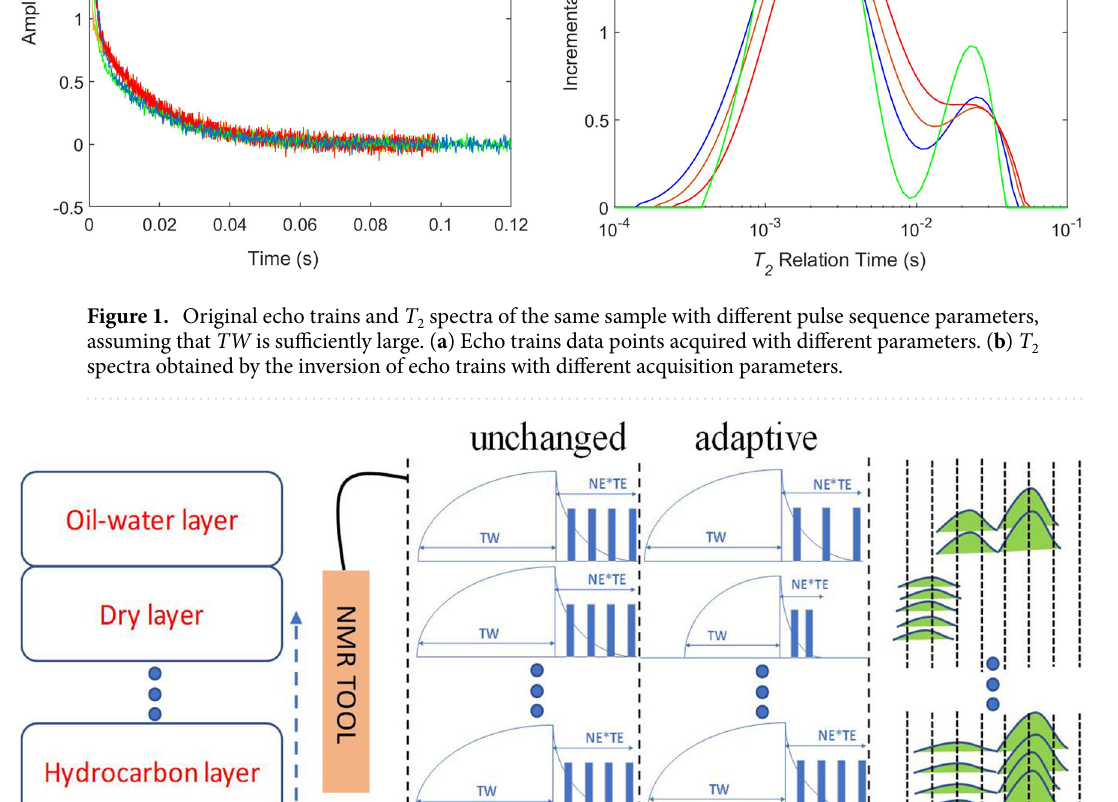
Figure 2. NMR logging tool for formation classification based on T2 spectra 33,34 . The design goal is to achieve real-time adjustment of pulse sequence parameters in different layers while the parameters in the conventional method remain